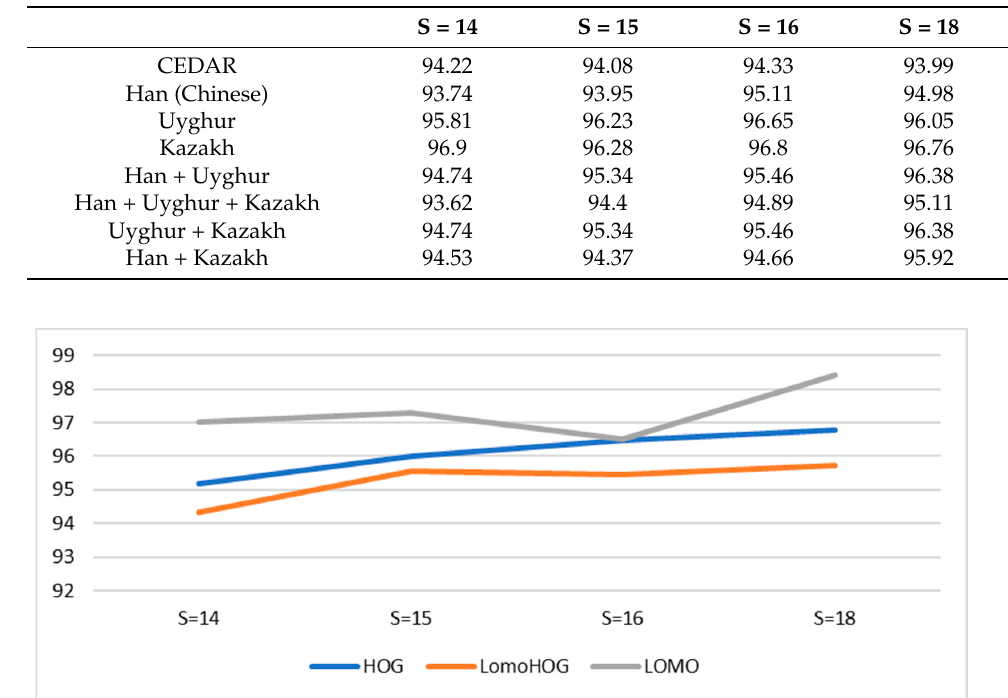
Figure 12. Experimental results of CEDAR signature extraction with different features. Table 7. Comparison of recognition results of CEDAR datasets based on different